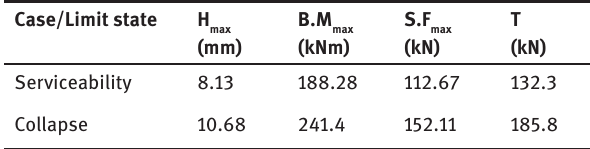
Table 8 Results of analysis with American code